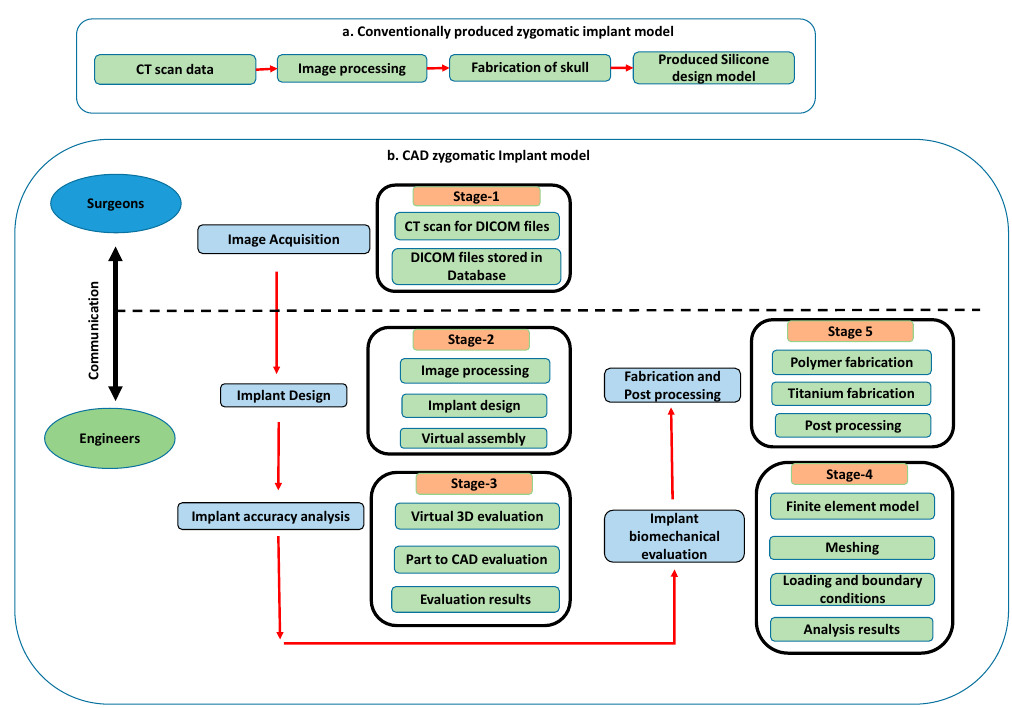
Figure 1. Methodology employed in the fabrication of ( a ) conventionally produced zygomatic implant model and ( b ) computer-aided-design zygomatic implant model.